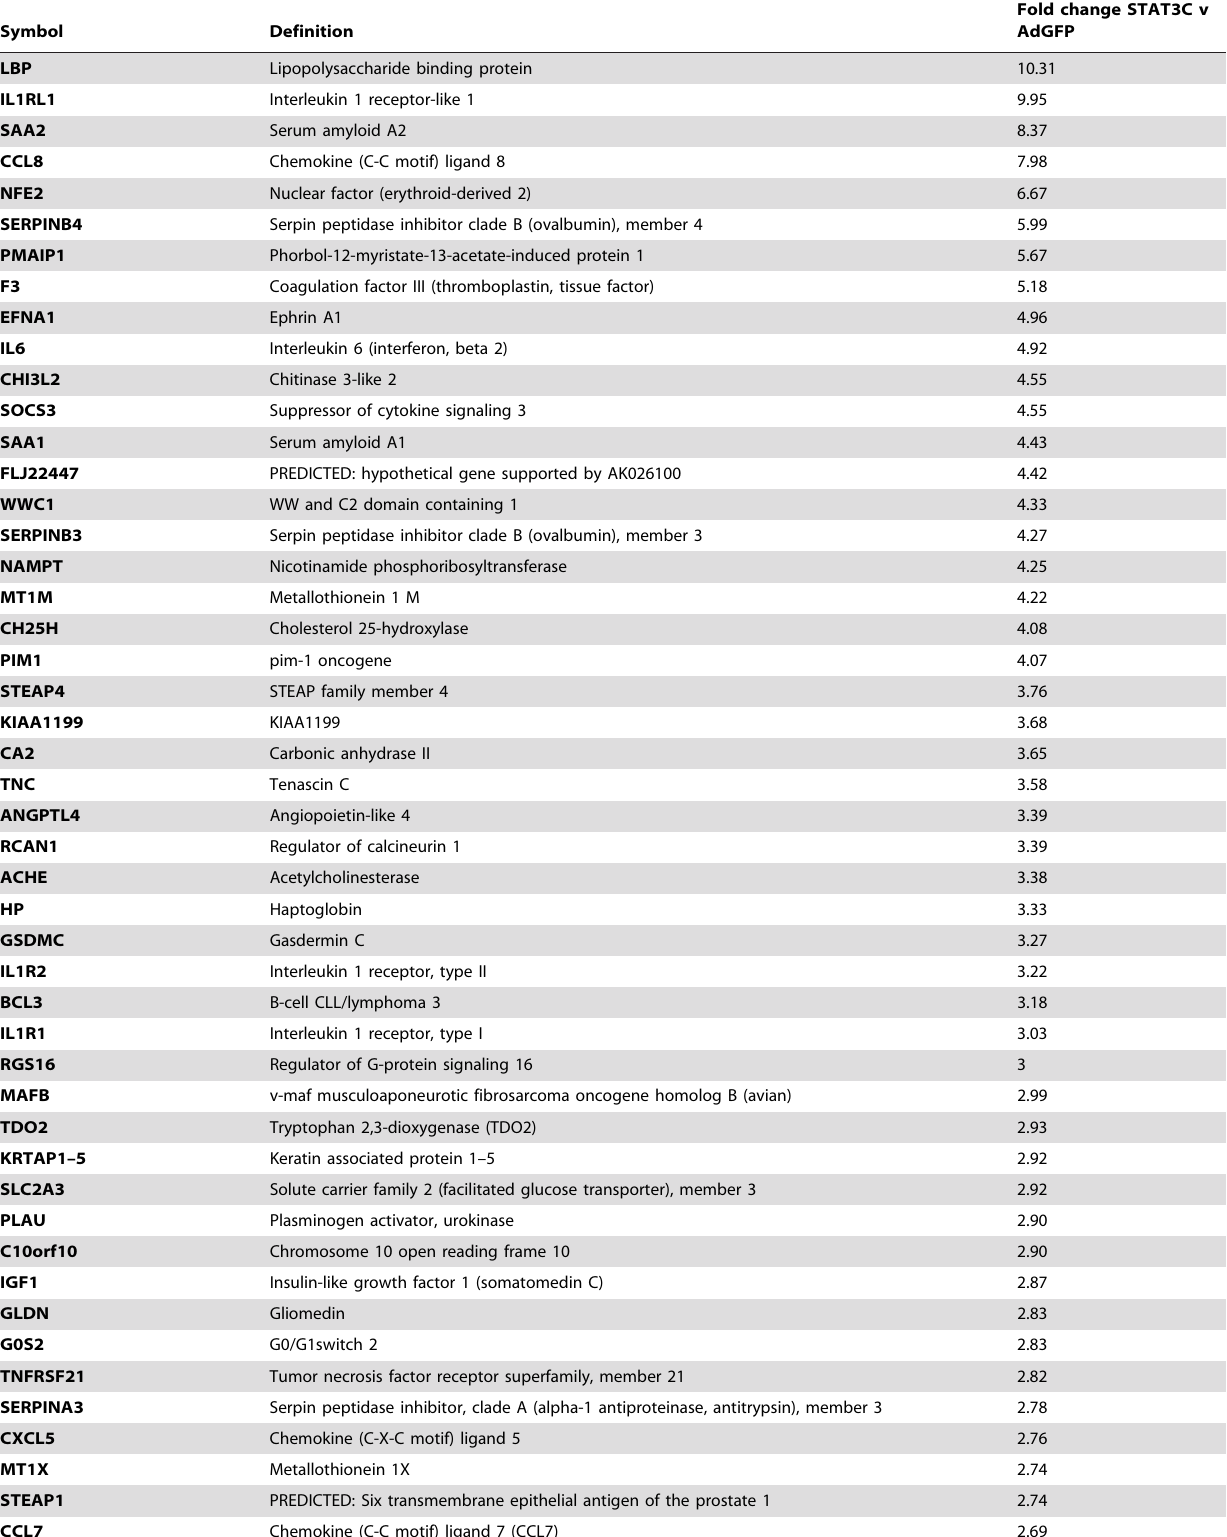
Table 1. Genes up-regulated by STATC.